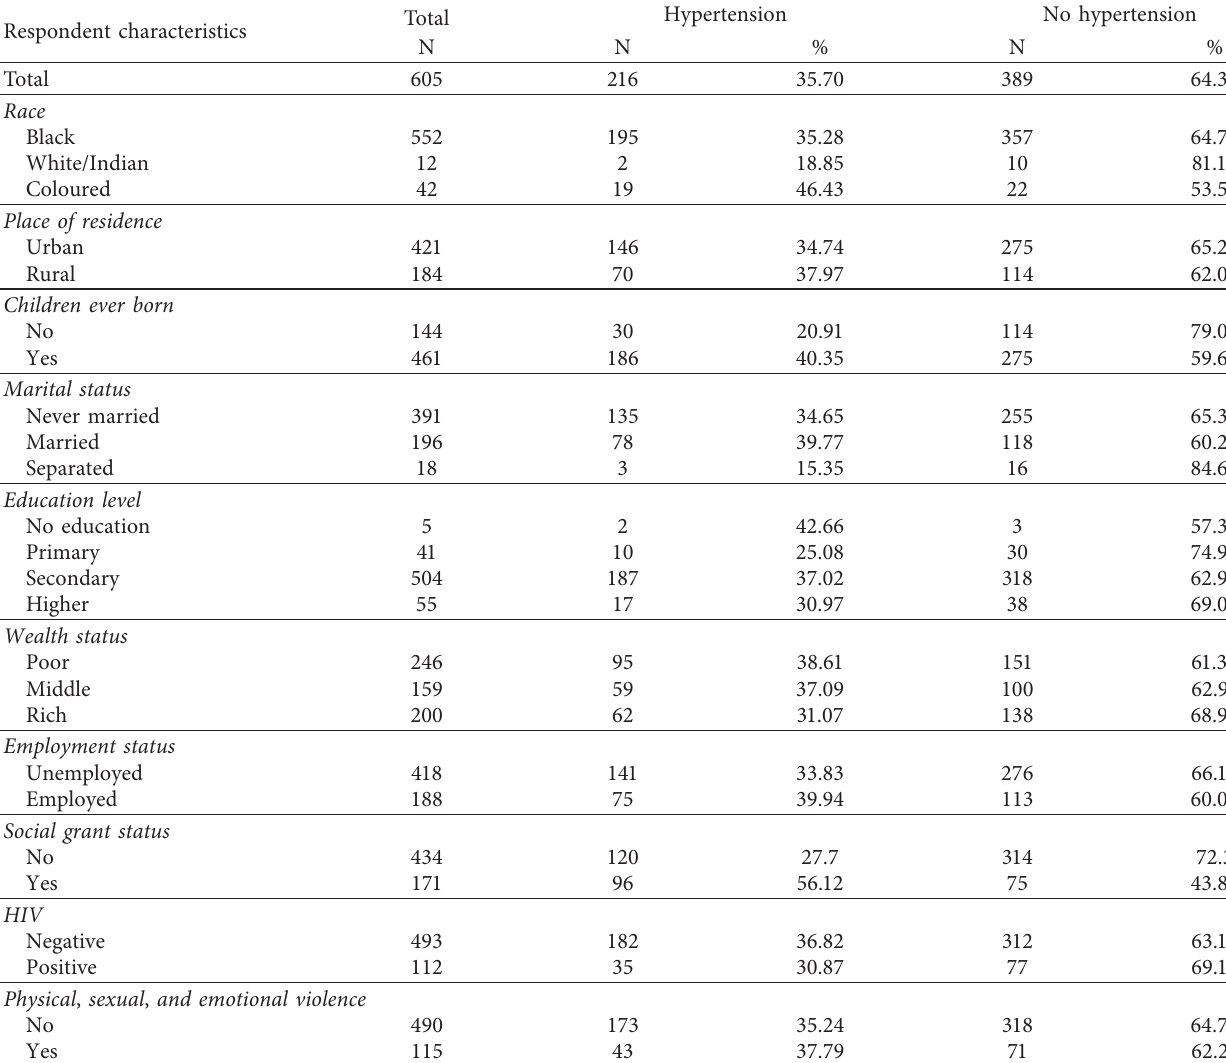
Table 1: Frequency and percentage distribution of respondents’ characteristics by hypertension status, South Africa, 2016. Respondent